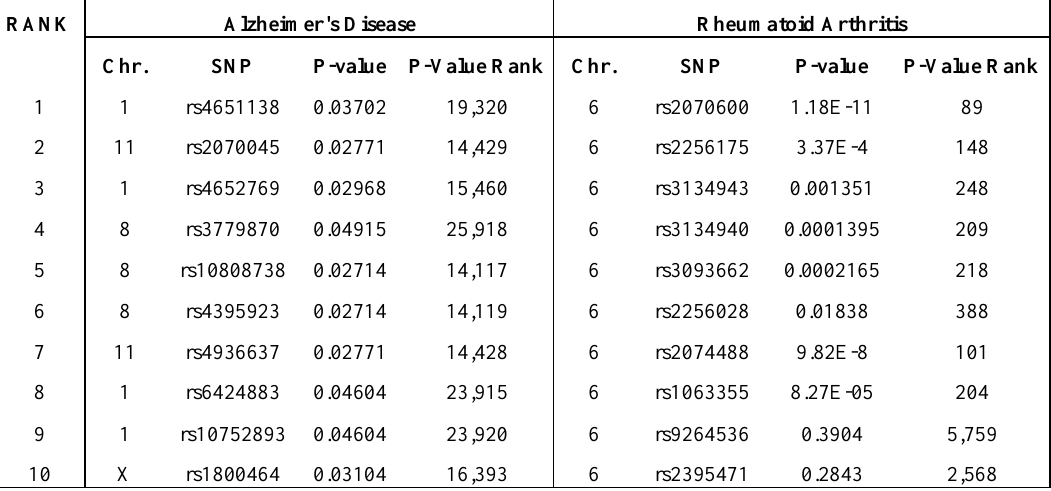
Table 12. Top 10 SNPs according AHP prioritization of GWAS for AD data and RA